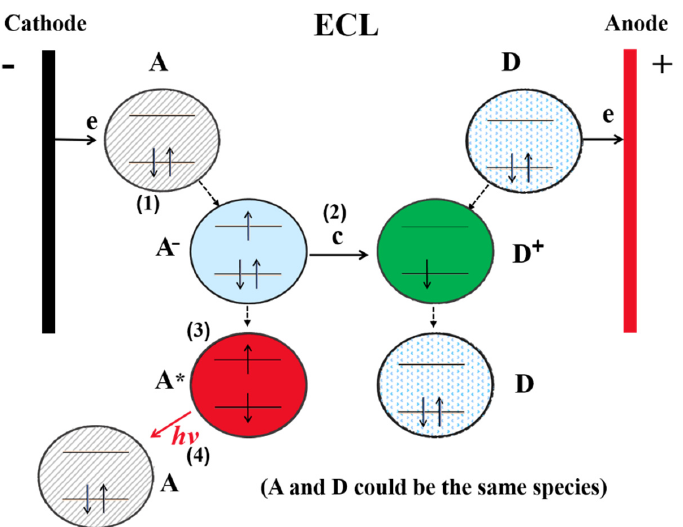
Figure 2. Scheme of ECL process. Reproduced with permission from Ref. [24]. Copyright 2017, Else ‐ vier.